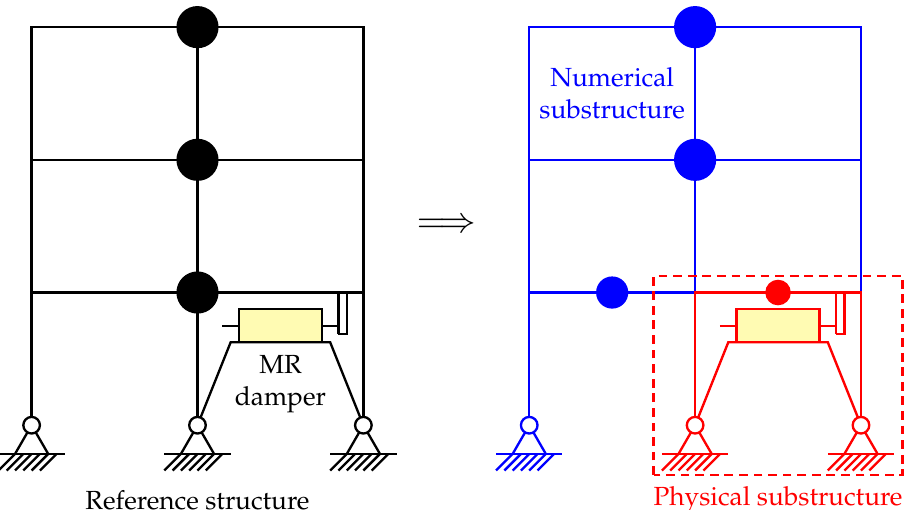
Figure 6. RTHS partitioning scheme.